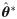
Transmission algorithm performance for estimated optimal grid size θ^*.Run time in seconds for simulations reaching 10, 100, 1000 and 10000 cumulative infected nodes. The grids were constructed using the adaptive gridding method using the estimated optimal grid size θ^* for each of the six different landscapes.